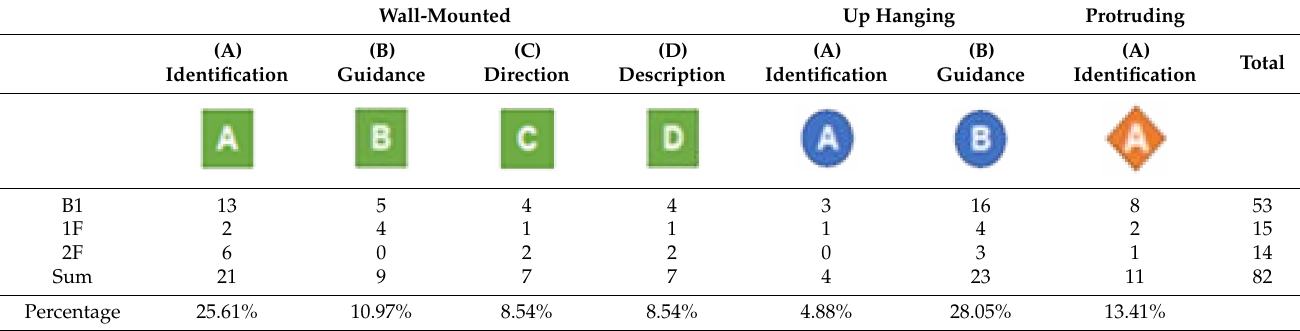
Table 1. Statistics on the number and type distribution of the signage on each floor. Wall-Mounted Up Hanging Protruding